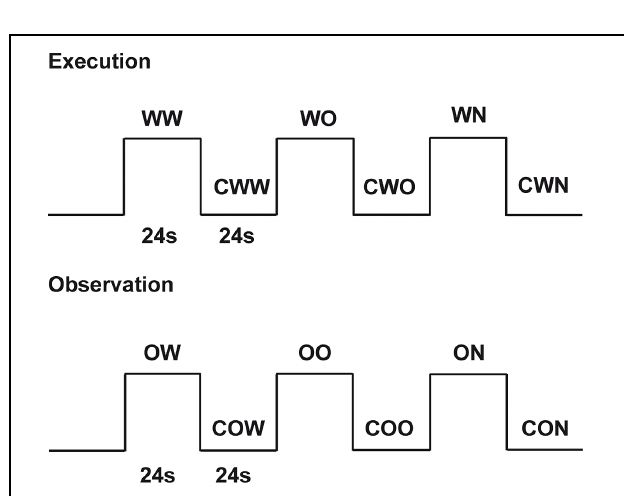
FIGURE 3 | Experimental design. Graphic representation of the experimental design used in the present experiment. Twenty-four seconds included 3 s for the presentation of a written instruction and 21 s of task